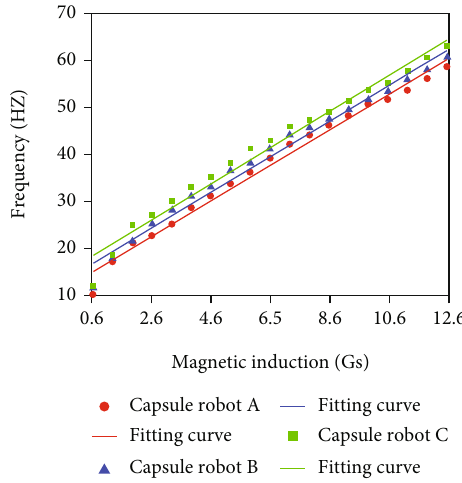
Figure 10: Cut-o ff frequency of di ff erent currents.